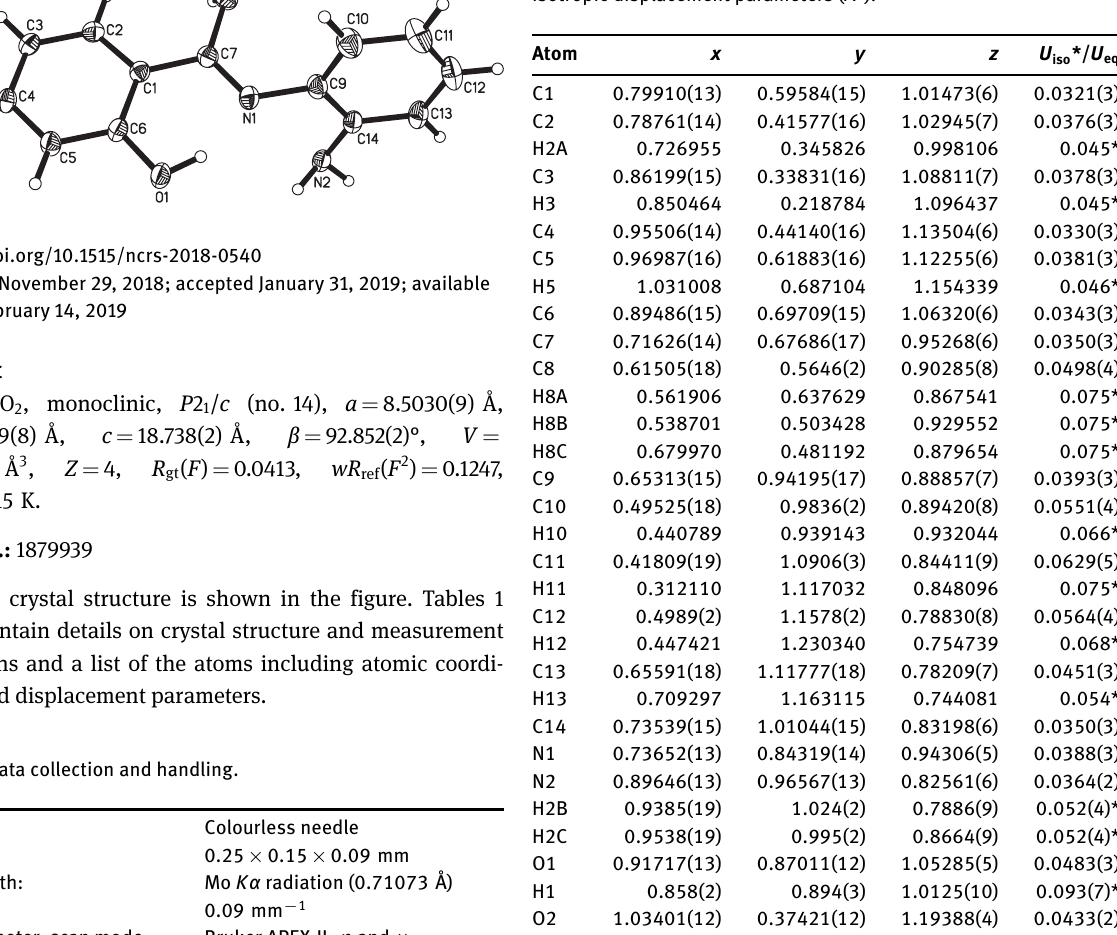
Table 2: Fractional atomic coordinates and isotropic or equivalent isotropic displacement parameters (Å 2